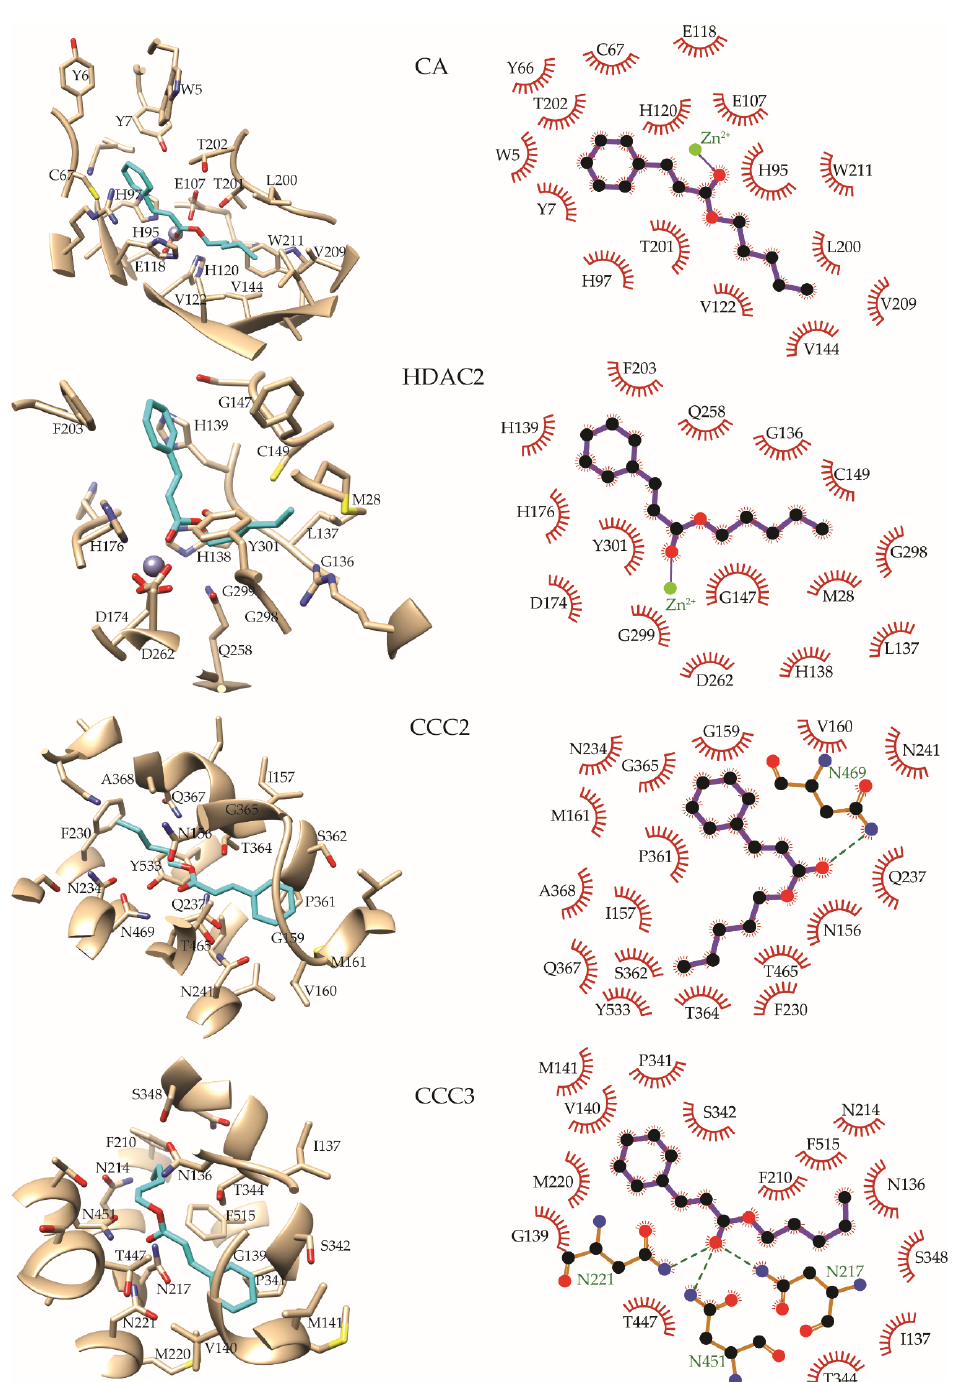
Figure 4. Predicted binding modes of compound 8 to CA, HDAC2, CCC2 and CCC3 (left) and the observed network of interactions with each target along the 200 MD snapshots used for Molecular Mechanics-Poisson-Boltzmann Surface Area (MM-PBSA) calculations (right). The receptors are depicted in gray and the ligand in cyan. Atoms are colored following the scheme: red for oxygen, blue for nitrogen and yellow for sulfur. Only residues interacting with the ligand on more than 50% of the analyzed MD snapshots are labelled. The Zn 2+ ions at the active sites of CA and HDAC2 are represented as purple spheres. In the interaction diagrams, all atoms are represented only for amino acids forming hydrogen bonds with the ligand. In these, hydrogen bonds are represented by dashed lines, carbon atoms are represented in black and the same color scheme as in the left pictures is followed for the rest of the ligand atom types.